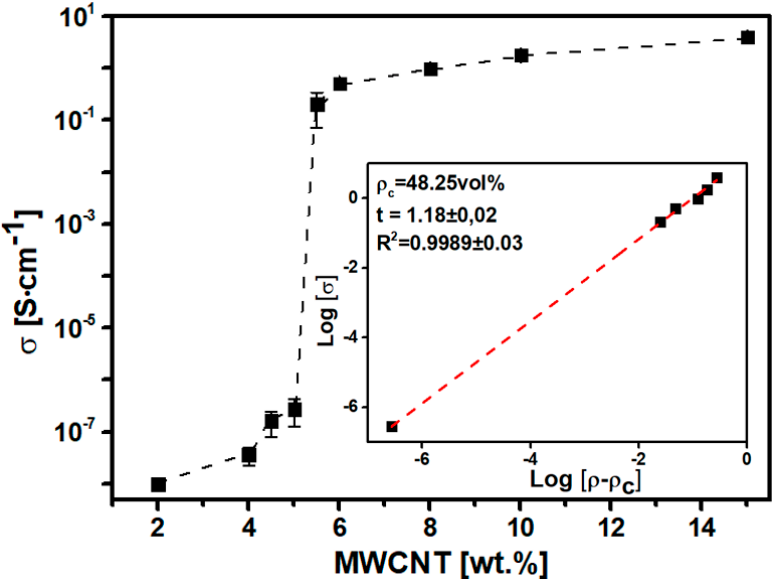
Figure 4. Electrical threshold of PLA/MWCNT composite and linear fit adjustment (inset).